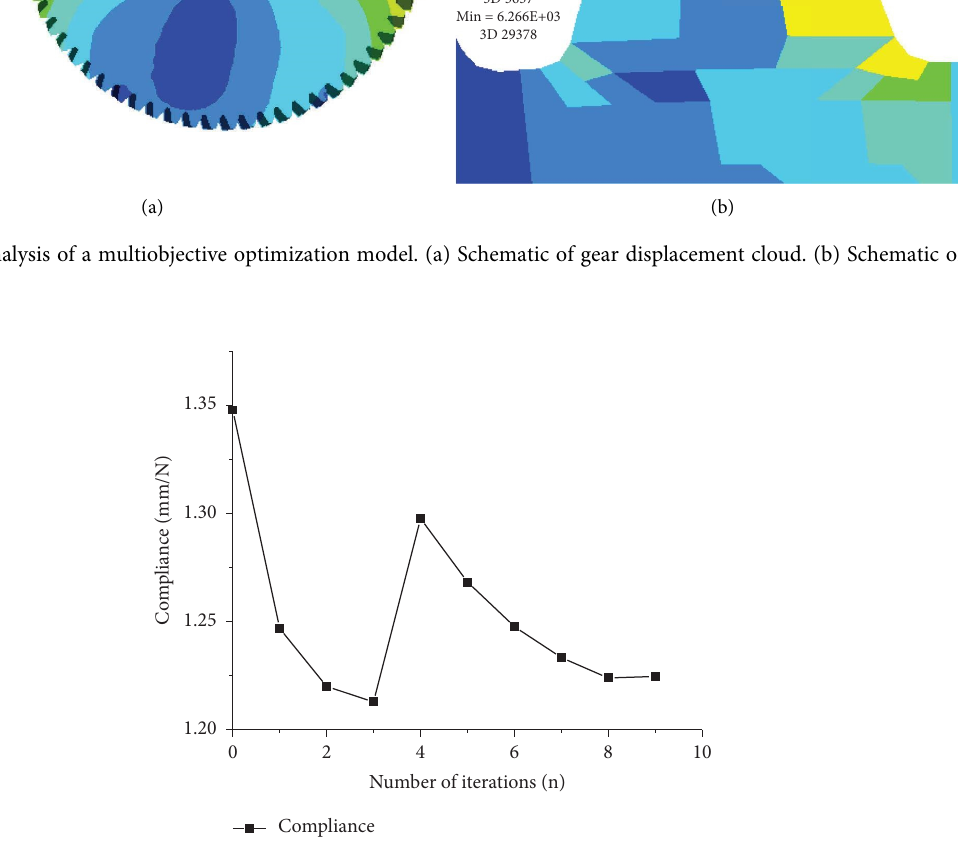
Figure 14: Schematic of the compliance iterative course of multiobjective